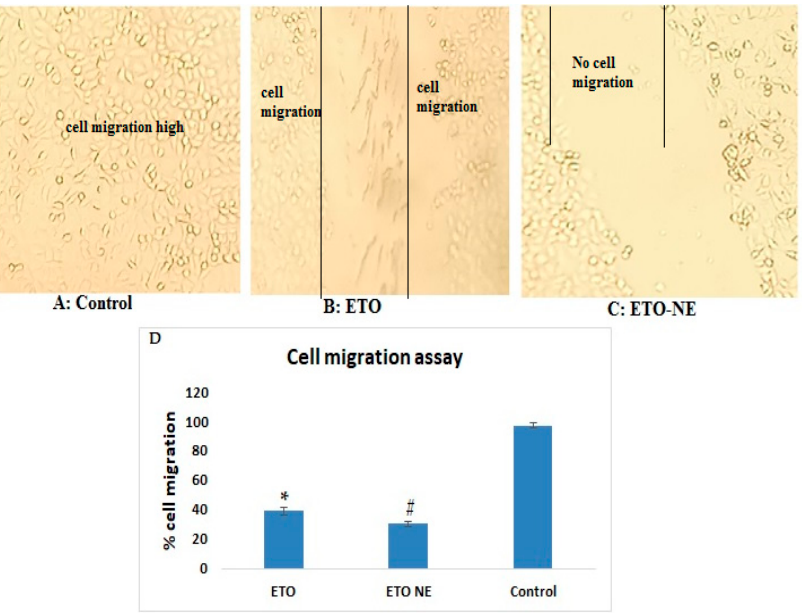
Figure 6. Effect of different formulations on percent cell migrated. The phase-contrast microscopy (10 × ) was employed to capture A549 cells migration and quantification with a scale bar of 100 µ m ( A – C ). ( D ) Effect of different formulations on percent cell migration. Data are expressed as (mean ± SD, n = 3) # denotes significant difference between ETO NE ( p < 0.05) vs. free ETO and control group. * denotes significant difference as compared to control group.